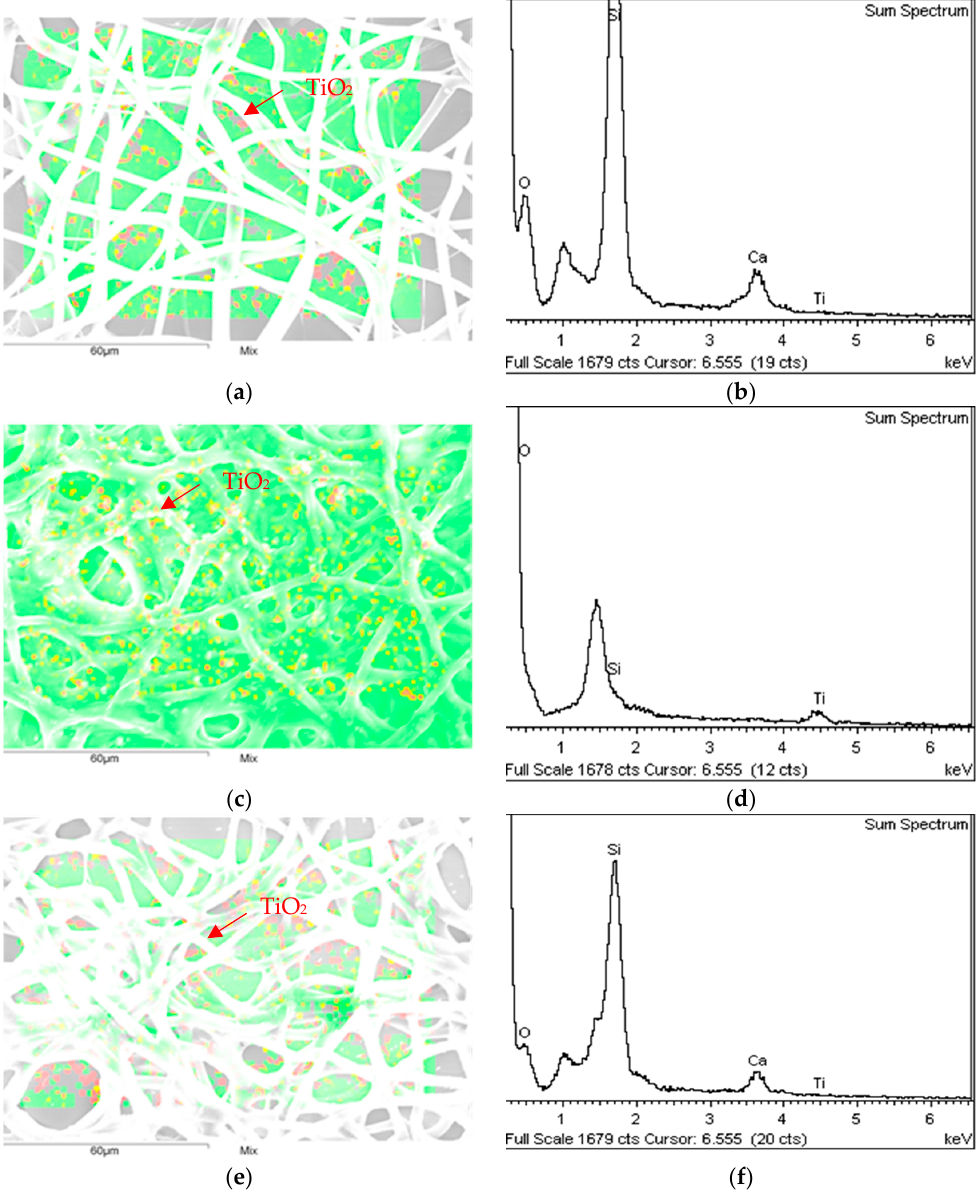
Figure 3. EDX graphs and 2D mapping for the analyzed samples: ( a ) TiO 2 nanoparticles shown by a 2D mapping of the ESpr sample; ( b ) Elements peaks in EDX graph of the ESpr sample; ( c ) TiO 2 nanoparticles shown by a 2D mapping of the Spr sample; ( d ) Elements peaks in EDX graph of the Spr sample; ( e ) TiO 2 nanoparticles shown by a 2D mapping of the Dip sample; ( f ) Elements peaks in EDX graph of the Spr sample.